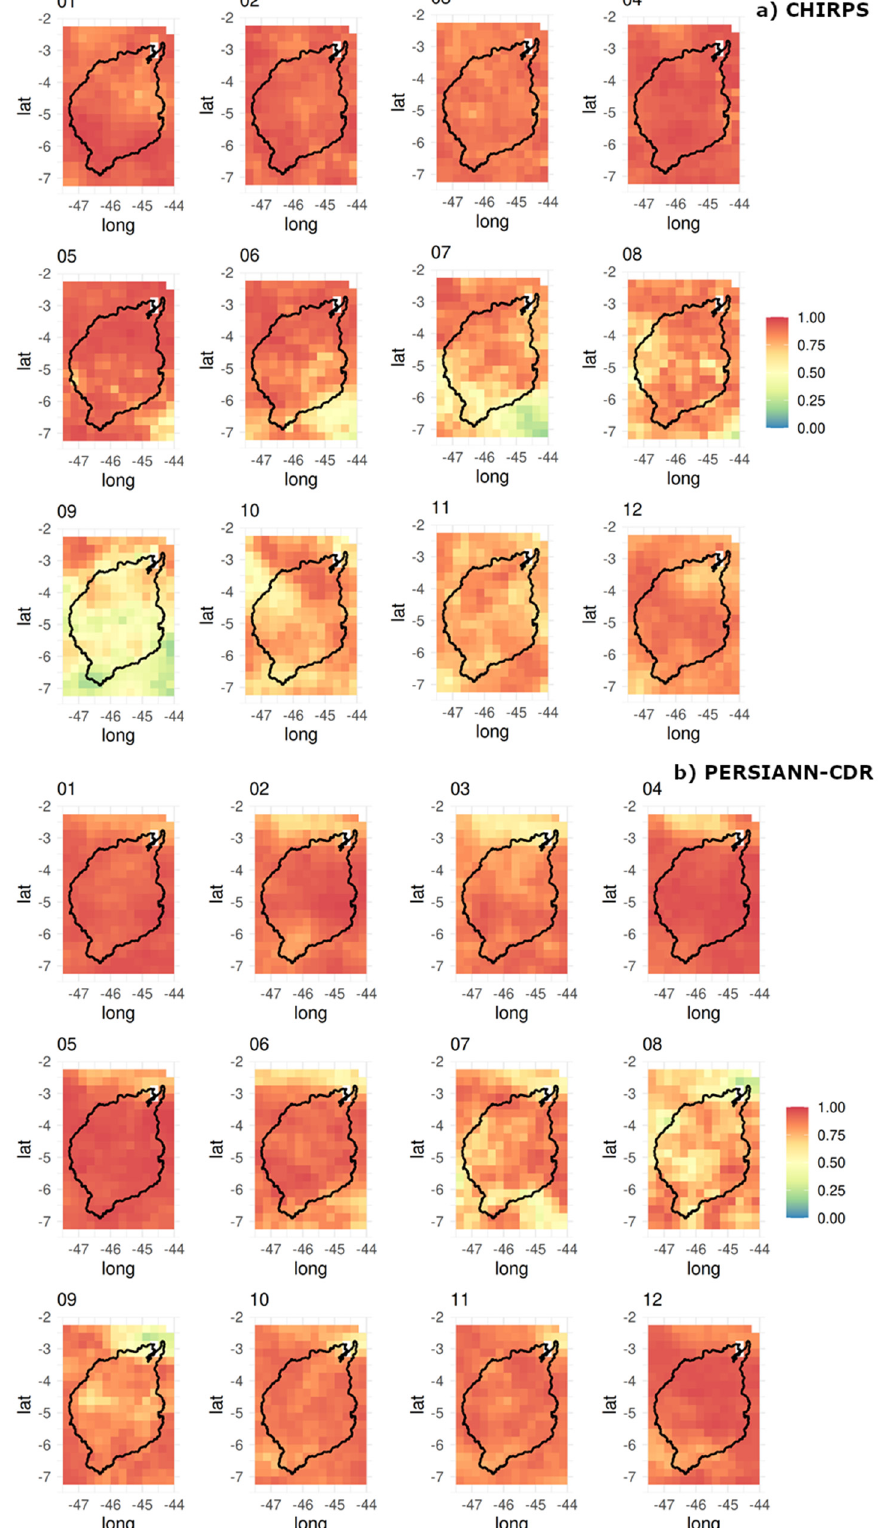
Figure 8. Willmott’s d (without units) monthly mean (gridBR × CHIRPS ( a ) and gridBR × PERSIANN-CDR ( b )) from January (01) to December (12) 1983 to 2013.